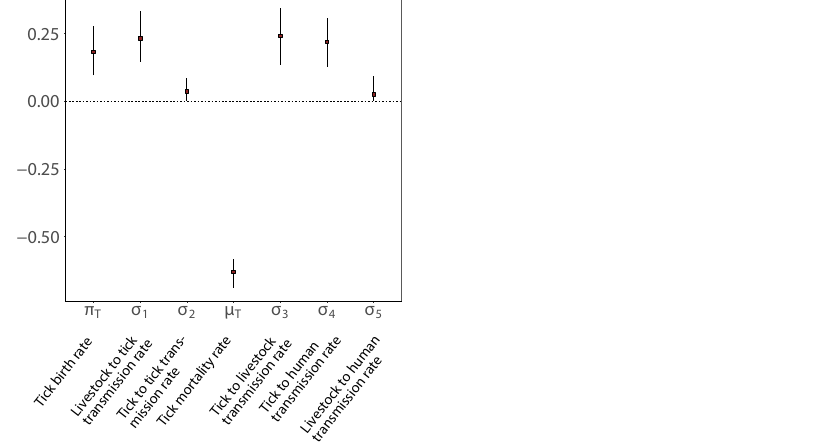
Figure 4. Sensitivity Analysis of the model using partial rank correlation coefficients. Only parameters with significant impact are shown. For all parameters see Supplementary Information (SI) (Section